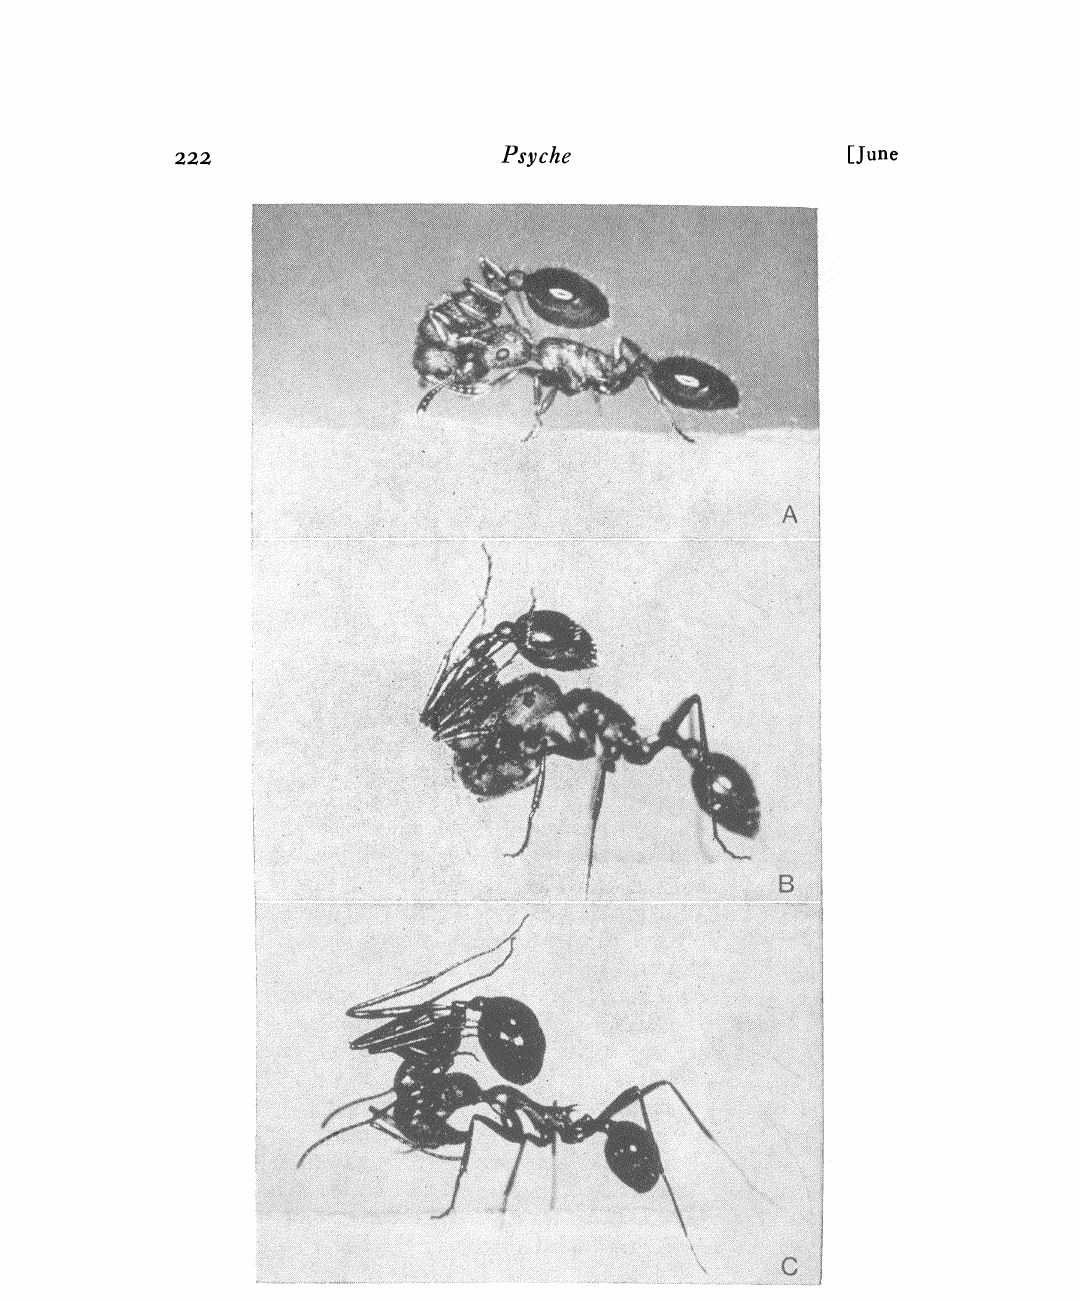
Fig. 2. Adult transport technique in myrmicine ants: A) Leptothorax nylanderi (worker carries worker). B) Pogonomyrmex maricopa (worker carries worker). C) Noomessor cockereIli (worker carries